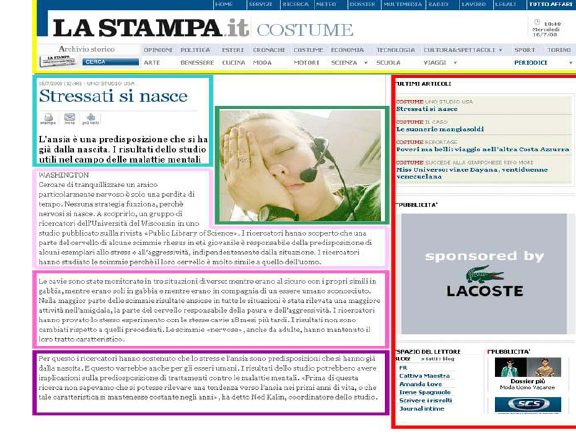
Figure 3 - Areas of Interest on CS1 story page.